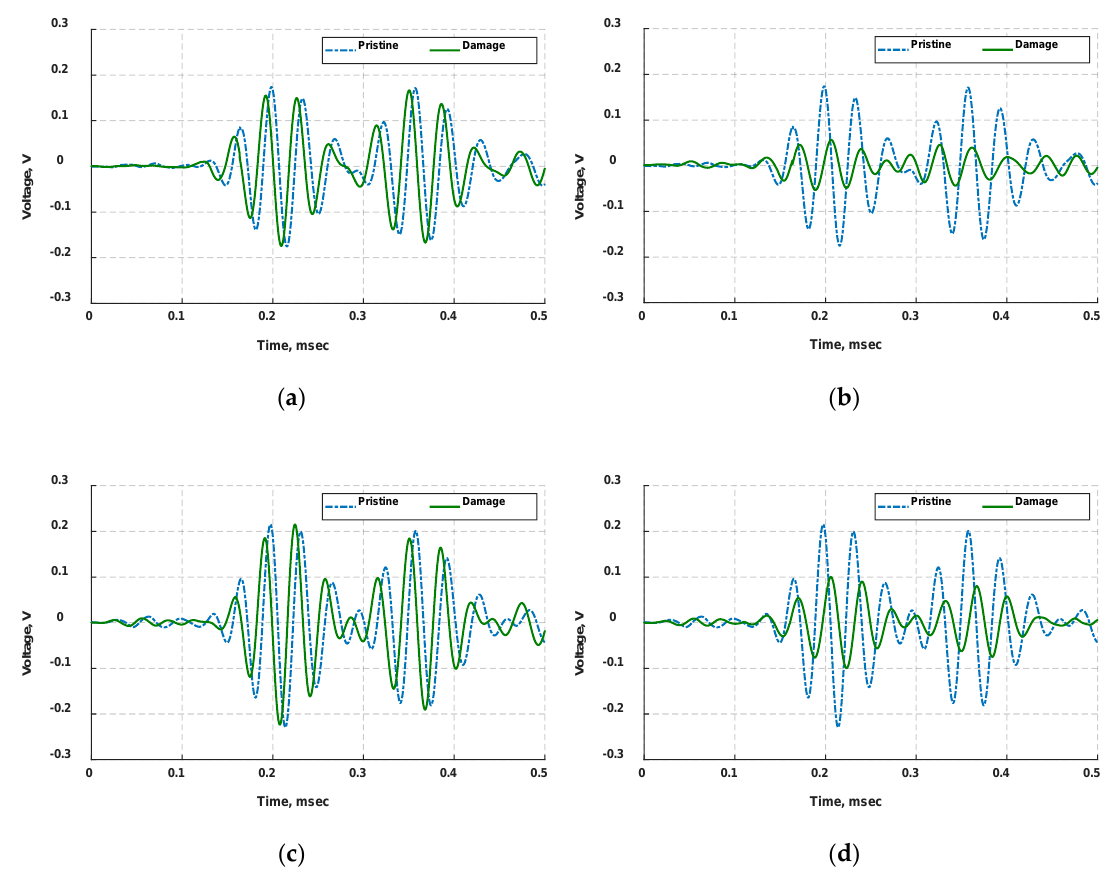
Figure 9. Comparison of waveform signals collected from bondline-embedded d15 PZT and surface mounted d31 PZT sensors at 1 mm deflection (left column) and 3.3 mm deflection (right column) for wave propagation paths: ( a , b ) PZT-1 → PZT-2 and ( c , d ) PZT-1 → PZT-3.